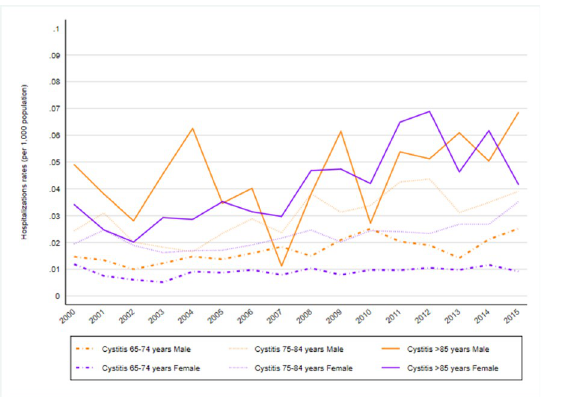
Fig 4. Cystitis. Cystitis hospitalization rates by sex and group of